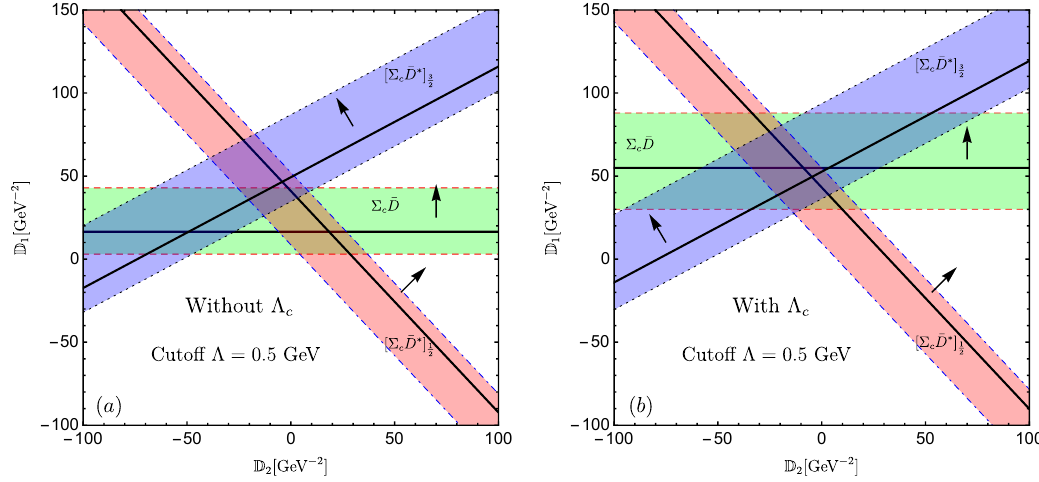
Figure 8 . The dependence of the binding energies of the three P c states on the rede(cid:12)ned LECs D 1 and D 2 . The green, red and blue bands correspond to the [(cid:6) c (cid:22) D ] systems, respectively. The three black straight lines represent the central values of the binding energies obtained from the experimental data [10] (the numbers in the (cid:12)fth column of table 1). The boundaries of the bands that are parallel to the corresponding straight lines stand for the regions of parameters with the binding emerges (cid:0) 30 MeV and 0 MeV, respectively. The accompanied arrow shows the direction that the each binding becomes deeper. Figures ( a ) and ( b ) illustrate the results without and with the (cid:3) c , respectively. The results are both calculated with the cuto(cid:11) (cid:3) = 0 : 5 GeV.